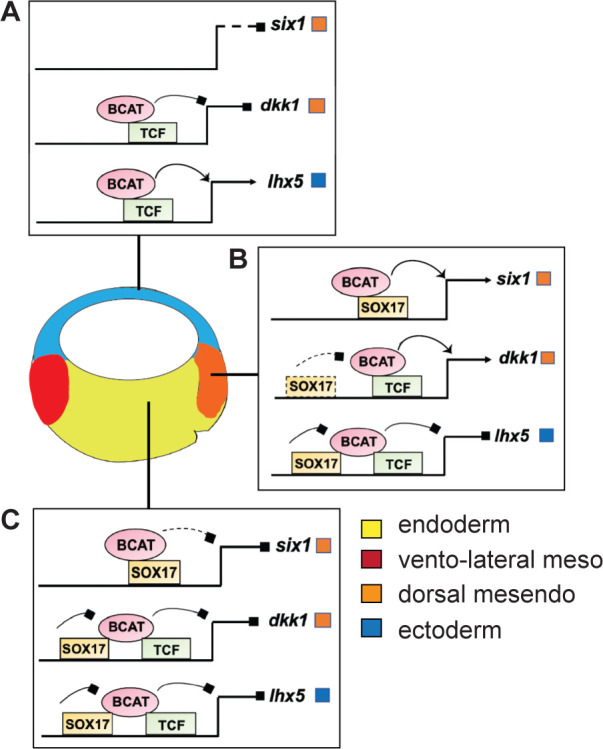
Model of Sox17 and Bcat coregulation spatial transcription.Differential engagement of Sox17, Bcat and Tcfs on enhancers in different cells modulates spatial expression domains. (A) In ectoderm cells lacking Sox17 (and Nodal signaling), ectoderm-specific gene lhx5 is activated through a Bcat/Tcf dependent mechanism while six1 and dkk1 are not transcribed. (B-C) Sox17 is expressed throughout the endoderm and dorsal mesendoderm, while Bcat activity is the higher in dorsal mesendoderm than deep endoderm. (B) In the dorsal region, Sox17 and Bcat synergistically coactivate six1 in the absence of Tcf, whereas Sox17 exerts a repressive influence on Bcat/Tcf-activation of lhx5 and dkk1. We postulate, however, that in the dorsal region Sox17-mediated repression is insufficient to overcome Bcat/Tcf activation of dkk1. (C) In deep endoderm cells where Bcat activity is lower, Sox17-mediated repression of Bcat/Tcf is sufficient to repress dkk1 and lhx5 transcription, but Bcat activity is not high enough to activate six1.